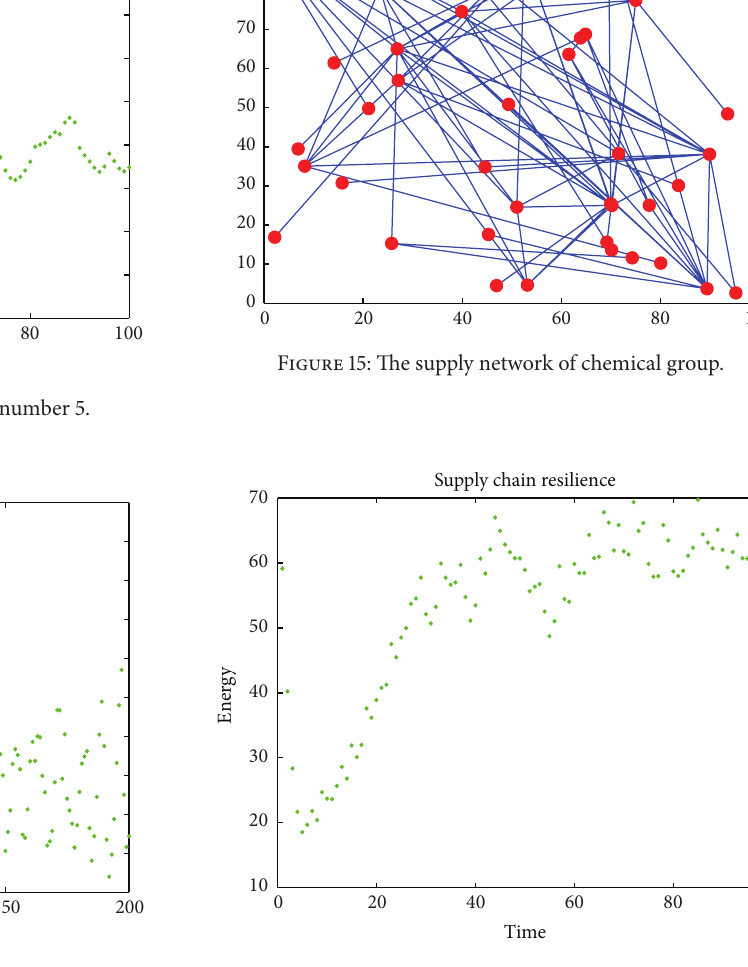
Figure 14: There is no resilience at SOC/number 5.